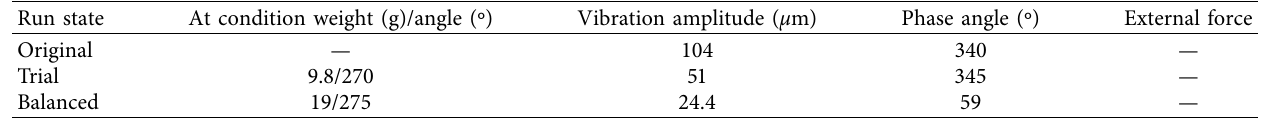
Table 9: Rotor balancing results using convention ICM without external